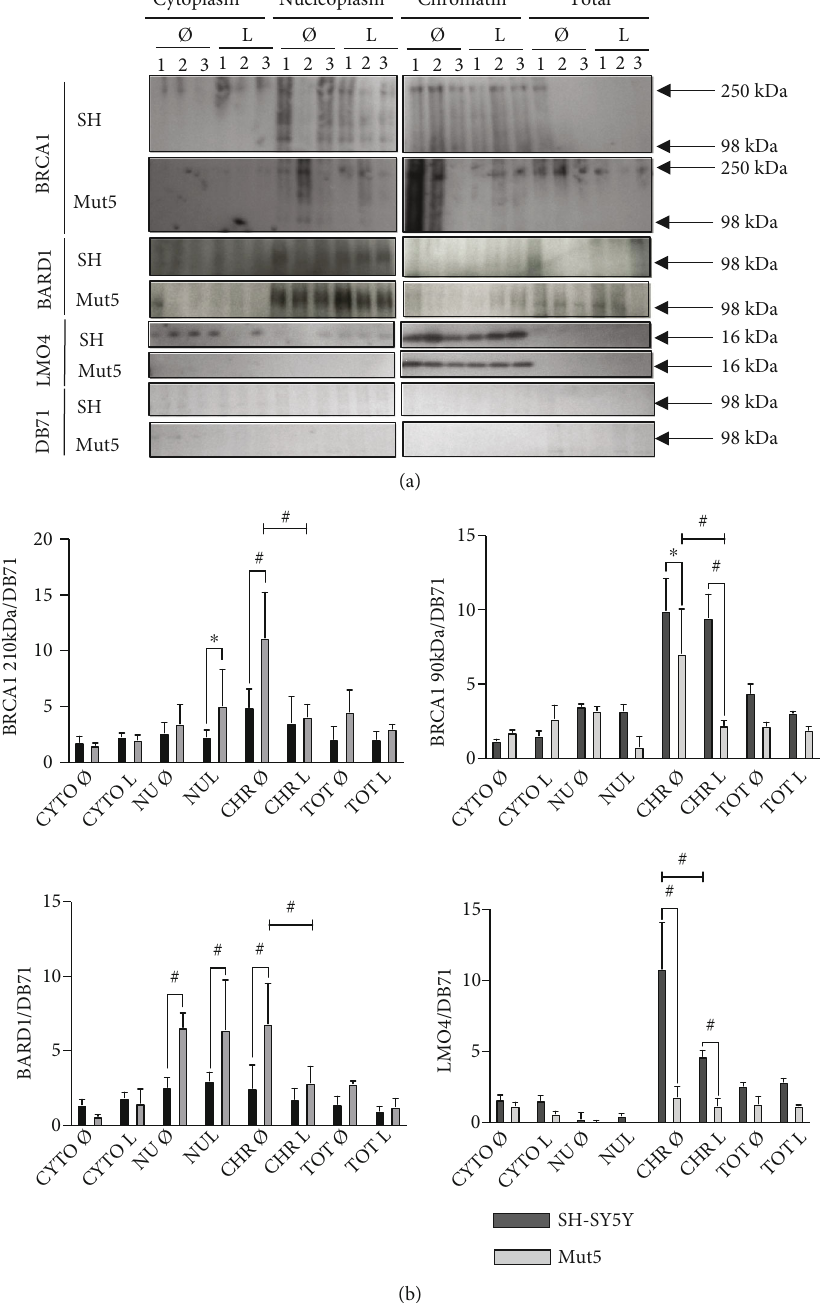
Figure 6: In (a), the SH-SY5Y cells (SH) and Mut5 clone were treated in triplicate (1, 2, and 3) with leptomycin B (L) for 30 min, or not, collected and fractionated in cytoplasm (CYTO), nucleoplasm (NU), and chromatin (CHR), or not (Total, TOT). Proteins BRCA1, BARD1, and LMO4 were then analyzed by Western blot. Equal loading was veri fi ed by DB71 staining. In (b), the statistical analyses of the experiment are presented (ANOVA with Tukey ’ s multiple comparison test: ∗ p < 0 : 05 ; ∗∗ p < 0 : 01 ; # p < 0 : 001 , n = 3 except for BRCA1 210kDa and BARD1: n = 6 ). We observed mainly higher expression levels of full-length BRCA1 (210kDa) and of full-length BARD1 in the chromatin fraction of the Mut5 compared to the SH-SY5Y cells. On the contrary, the 90kDa BRCA1 isoform and similarly a 110kDa and a 140kDa (di ff erence only with leptomycin B) band (statistics not shown), as well as the LMO4 protein, were signi fi cantly decreased in expression in the chromatin